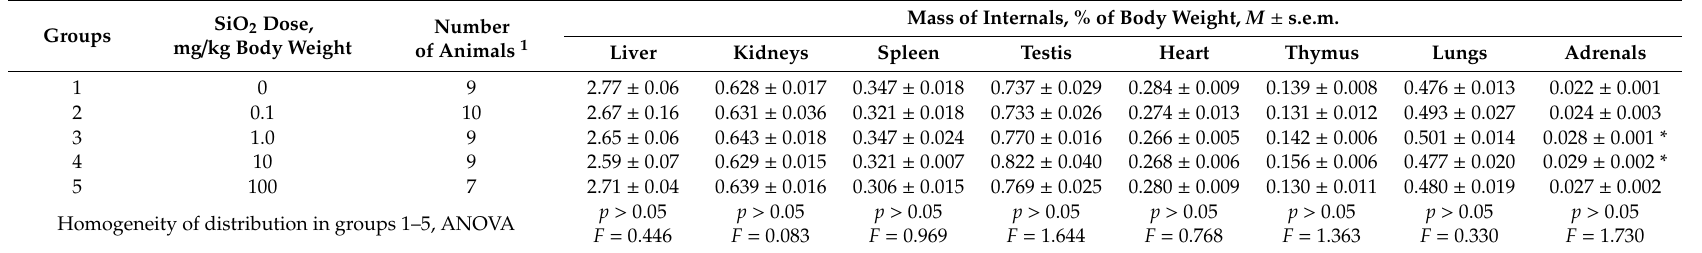
Table 1. Relative weights of rats’ internal organs in groups 1–5 on the 93rd day of the